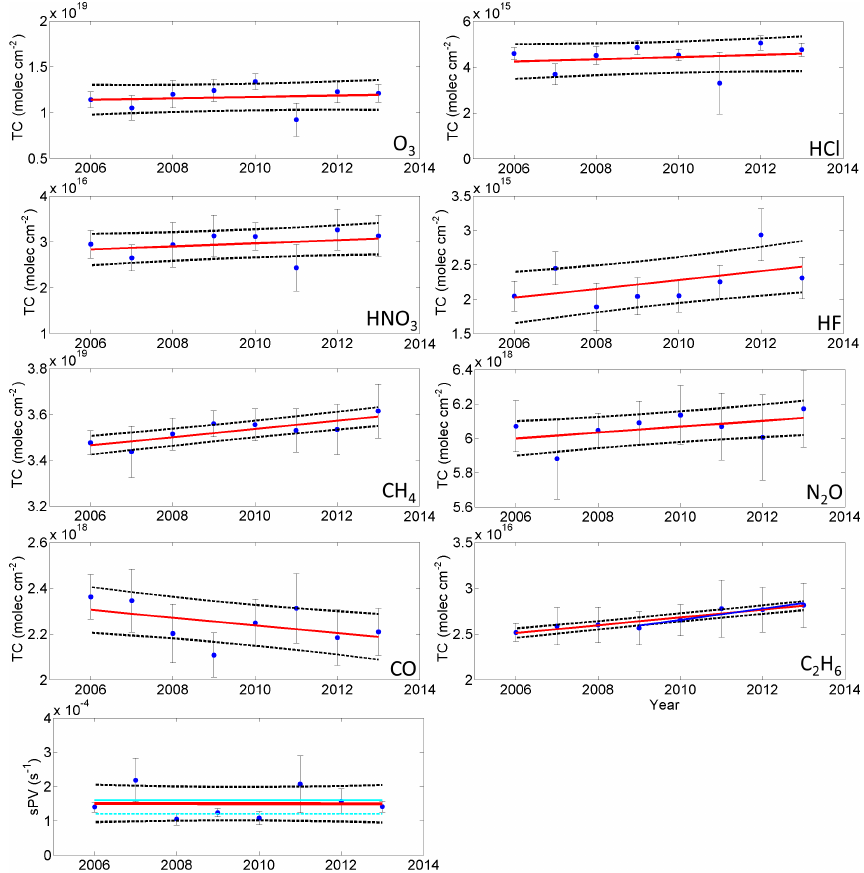
Figure 5. Yearly springtime campaign averages (blue dots) and 1 σ standard deviation (error bar) between 2006 and 2013 obtained from the PARIS-IR total column retrievals for all eight trace gases used in this study. The sPV at 20km along the line of sight is shown in the lower panel, together with the inner (solid cyan line) and outer (dashed cyan line) edge of the polar vortex. The red solid lines represent the lines of best fit and the black dashed lines display the 1 σ standard deviation of the fit. The best fit between 2009 and 2013 is displayed for C 2 H 6 as a dark blue line.